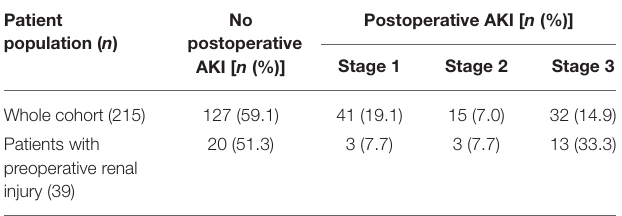
TABLE 4 | Patient characteristics categorized by KDIGO